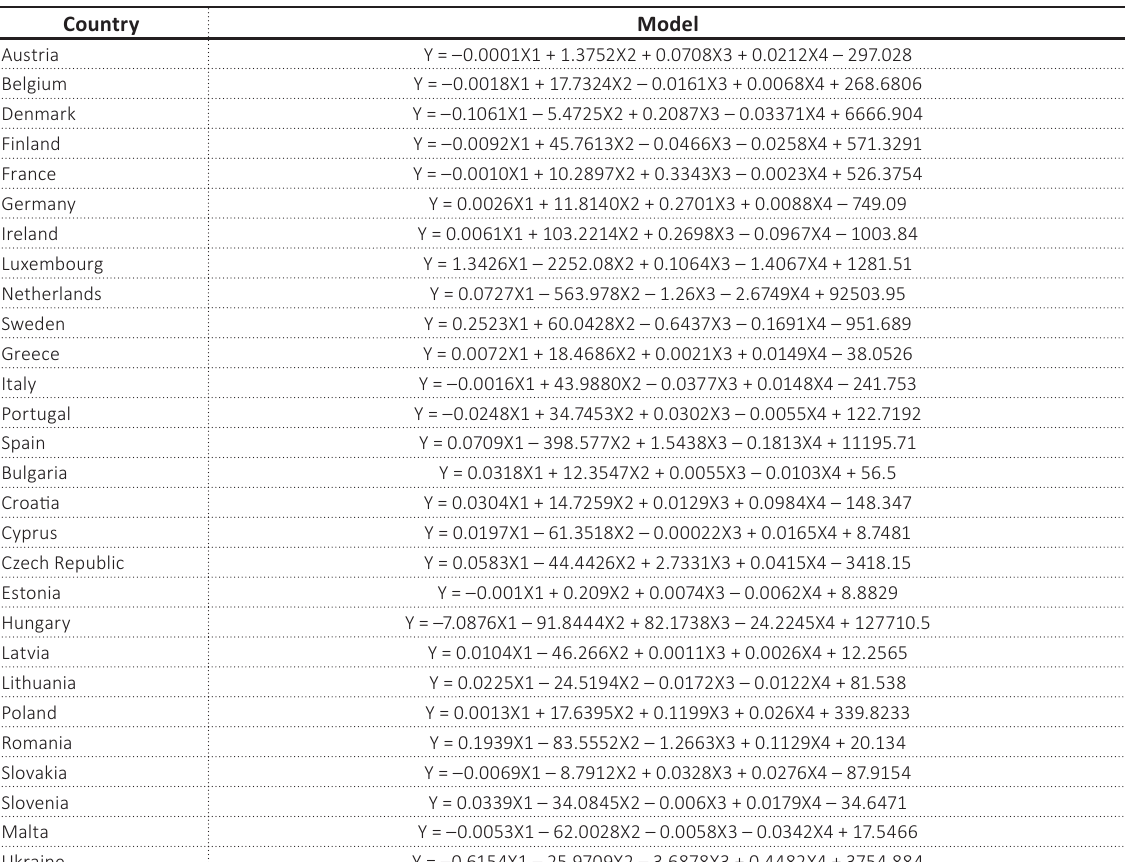
Table 2. Mathematical models of GDP dependence of Ukraine and European countries on four groups of factors